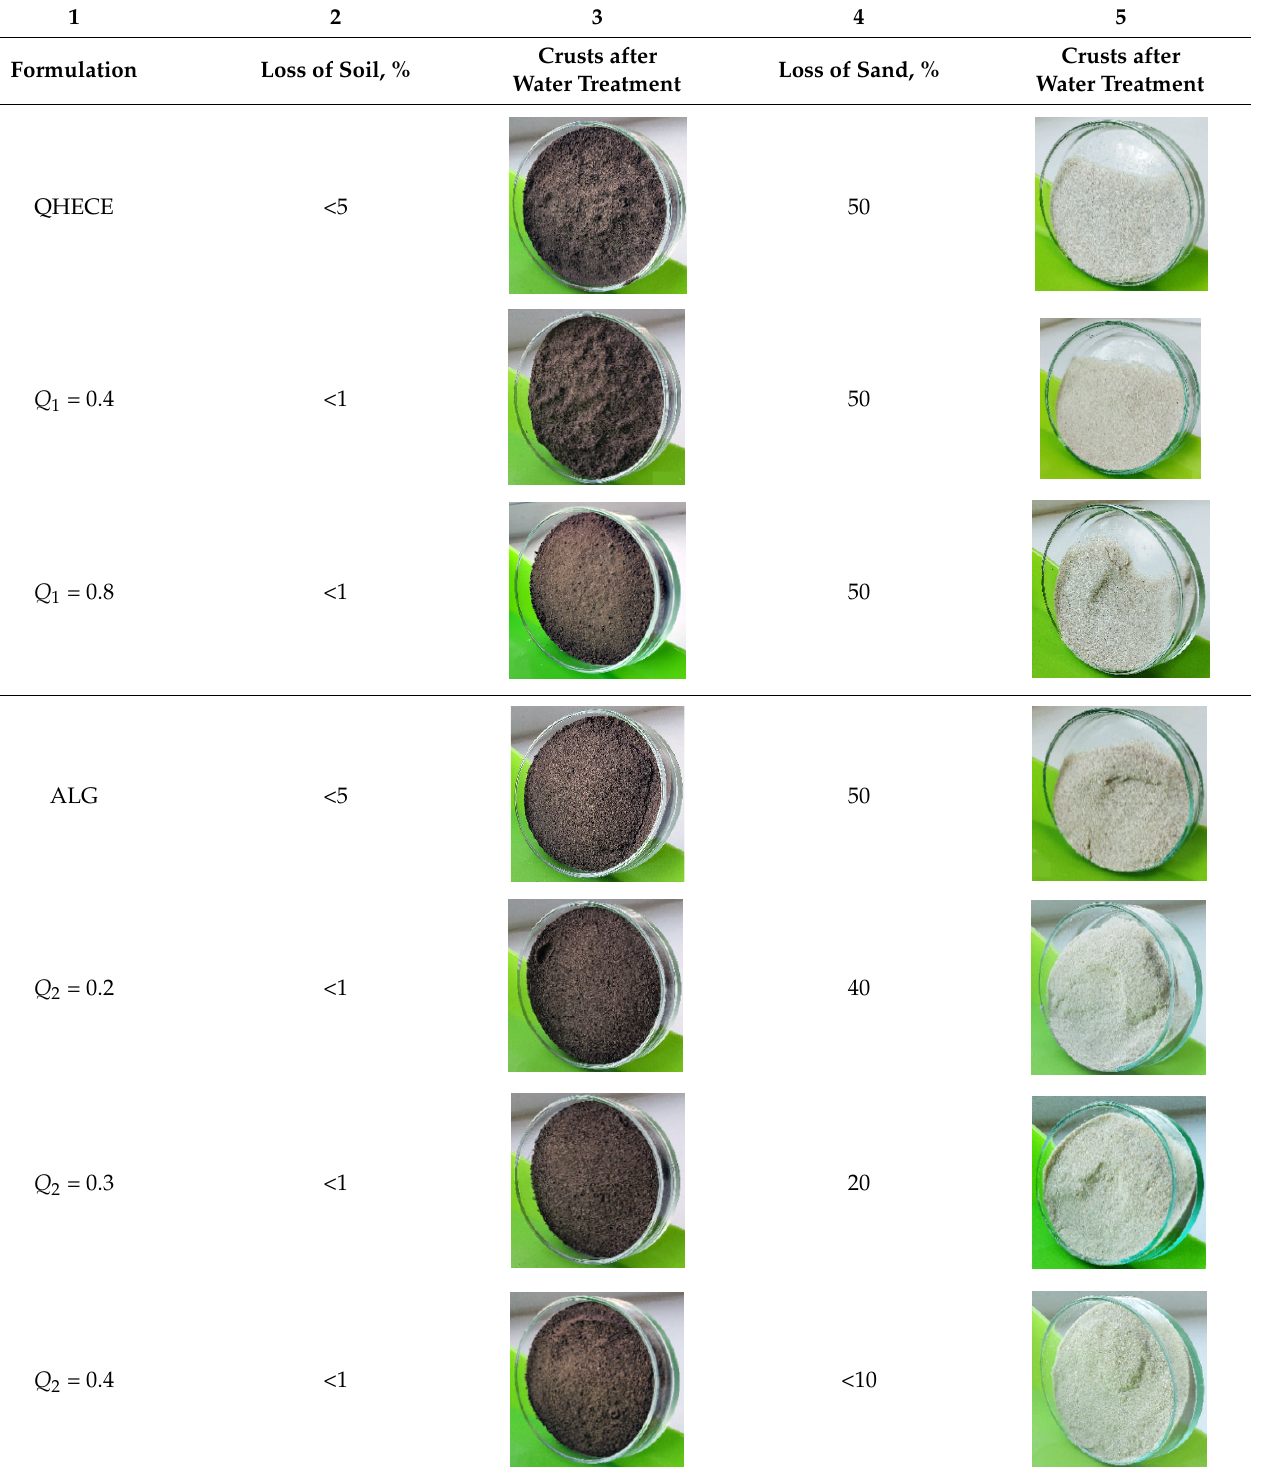
Table 1. Resistance of polymer–soil/sand crusts to water erosion.